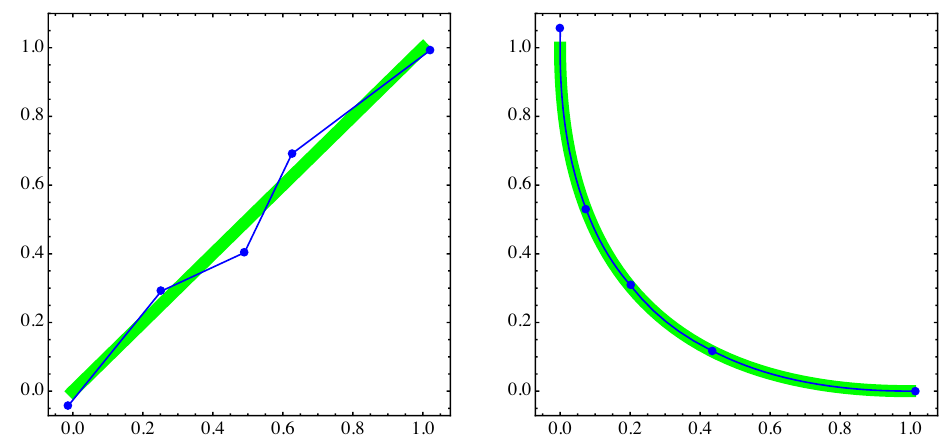
Figure 7. Left: Approximations A (blue dots) and B (blue polygon line) of the Pareto set (green thick line) of MOP (12) for n = 2. Right: corresponding approximations F ( A ) and F ( B ) of the Pareto front, for γ = 2.